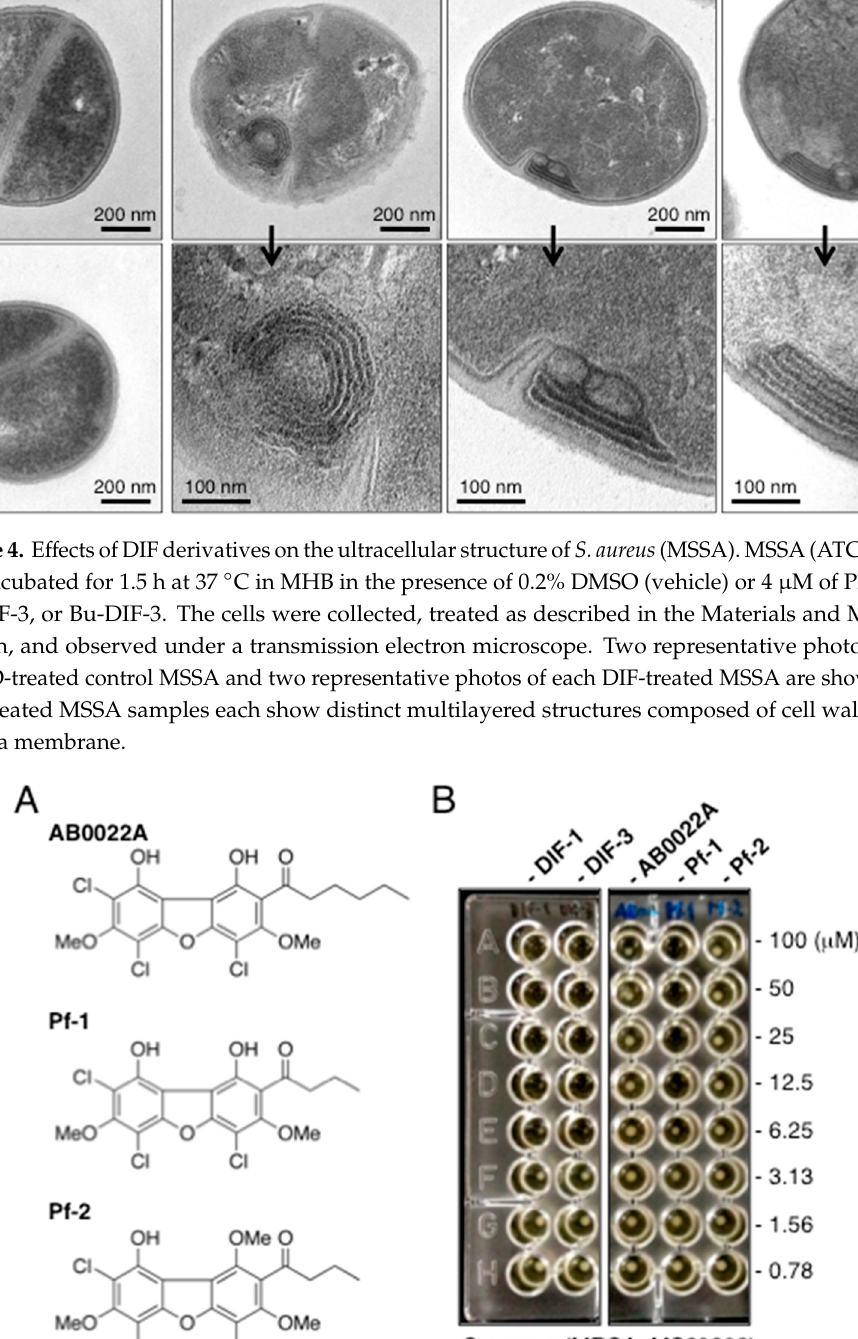
Figure 5. ( A ) Chemical structures of the chlorinated dibenzofurans AB0022A, Pf-1, and Pf-2. ( B ) Effects of chlorinated dibenzofurans and DIFs on the growth of S. aureus (MRSA). MRSA (MS29202) was incubated for 20 h at 37 °C in the presence of the indicated concentrations of DIF-1, DIF-3, AB0022A, Pf-1, or Pf-2, after which colony formation was noted for determining the MICs of the